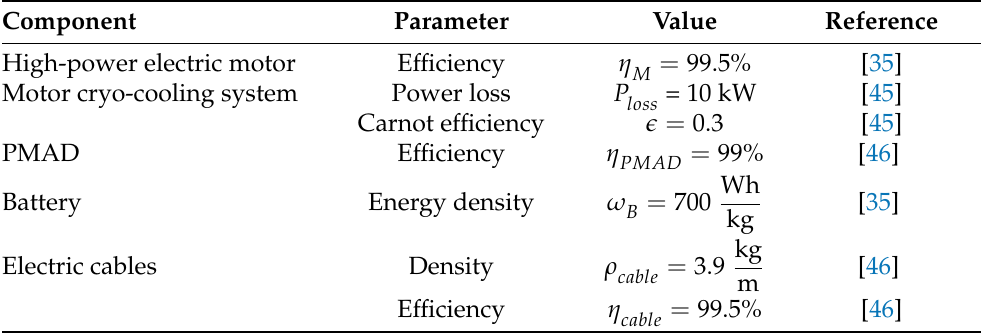
Table 1. SE 2 A SR energy network